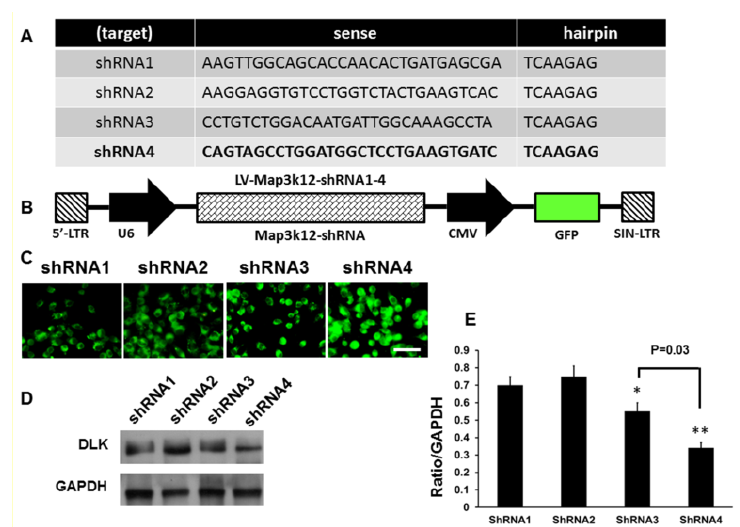
Figure 3. Construction of short hairpin RNA (shRNA) of DLK for the assessment of the inhibitory effect after intrathecal injection in fours rings CCI model. ( A ) Four specified sequence of shRNA targeting DLK were searched from OriGene web site (www.OriGene.com/shRNA). ( B ) Schematic presentation of the plasmid vector and encoded GFP protein and DLK shRNA sequence. ( C ) The representative of 293T mammalian cells infected by the different sequence of DLK shRNA. ( D ) Representative of Western blot analysis of DLK expression in dorsal root ganglion cells subjected to intrathecal injection of DLK shRNA. ( E ) Quantitative analysis of Western blot analysis of DLK in dorsal root ganglion cells. Bar length = 200 µ m; * p < 0.05; ** p < 0.01. GAPDH: glyceraldehyde-3-phosphate dehydrogenase; CMV: Cytomegalovirus; SIN-LTR: Self-Inactivating- Long terminal repeat.